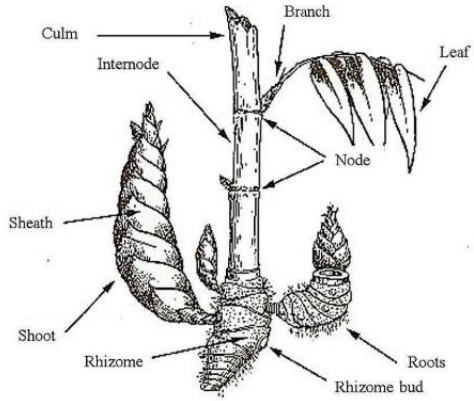
Figure 2. Bamboo anatomy [36].